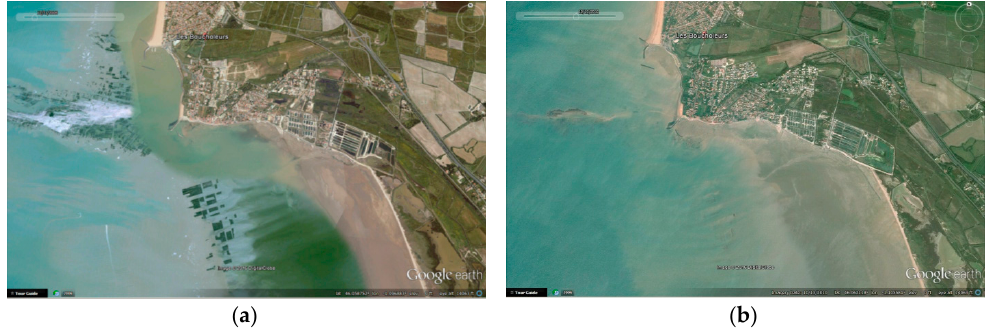
Figure 17. Satellite images documenting the change of landscape in the commune Les Boucholeurs